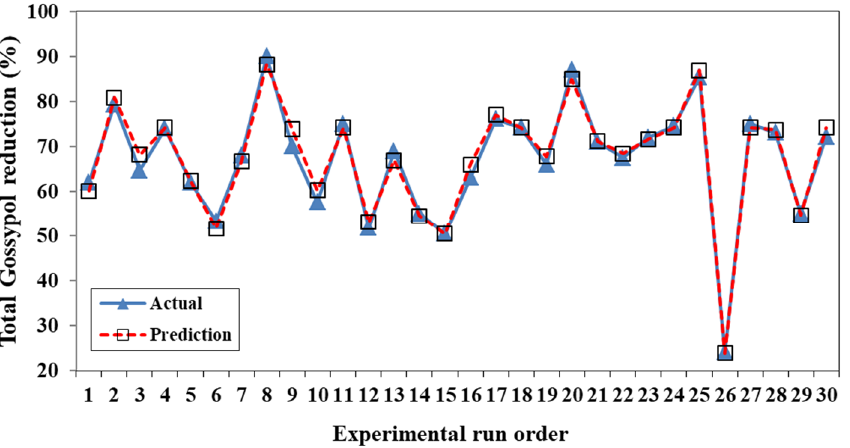
Figure 4. Comparison between measured and predicted values for TGR.